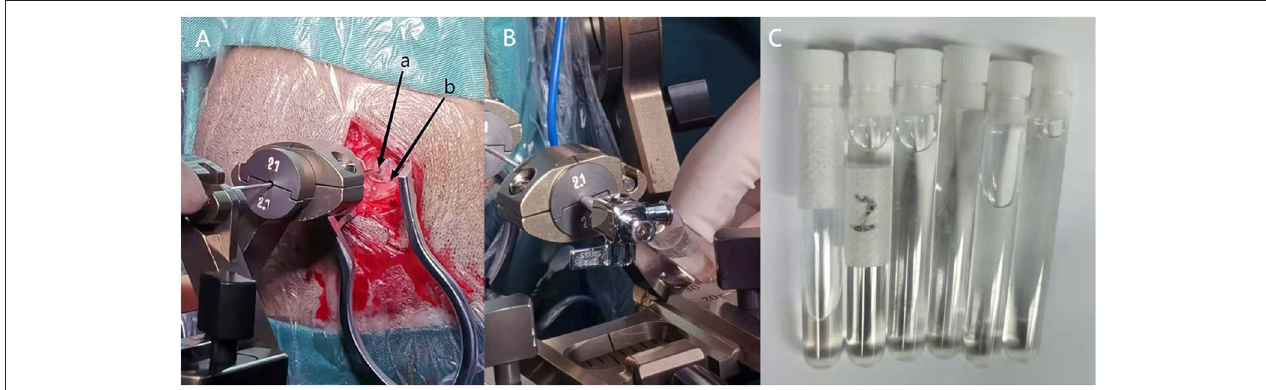
FIGURE 2 | (A) Stereotactic cyst puncture is performed (a: Brain puncture needle hole, b: previous electrode hole). (B) The clear cyst fluid will flow out automatically after the brain puncture needle into the cyst. (C) About 25ml clear cyst fluid drained through stereotactic cyst aspiration.